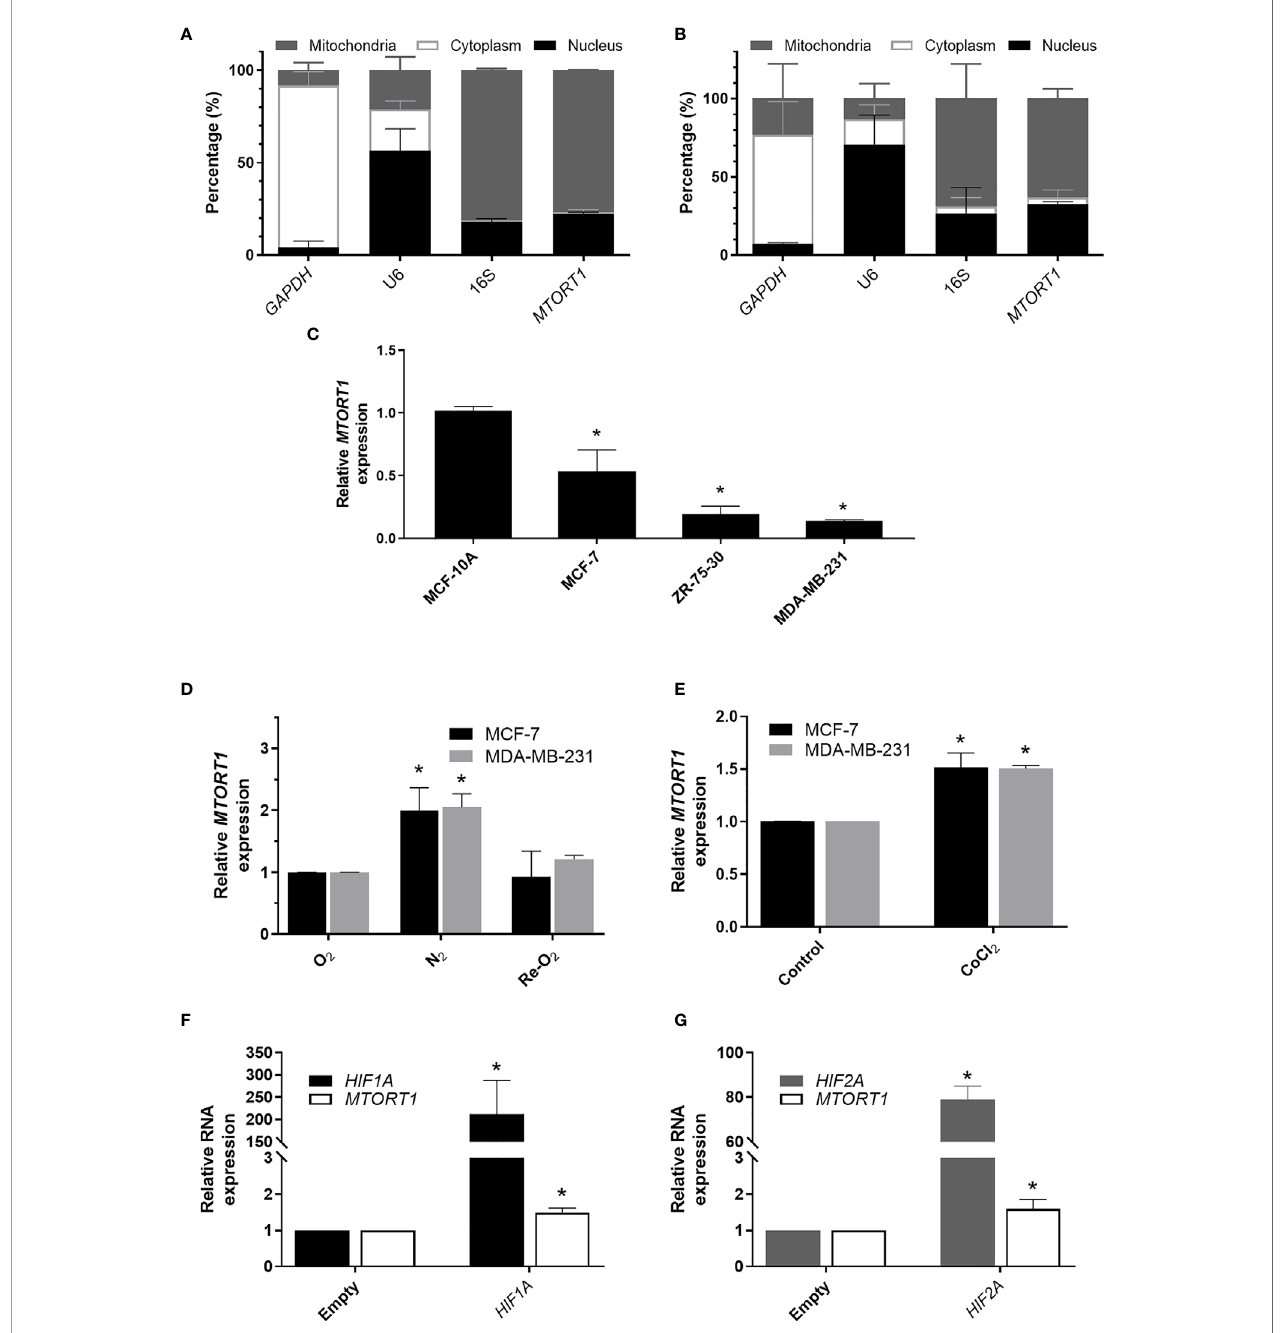
FIGURE 1 | The mitochondrial lncRNA MTORT1 is up-regulated under hypoxia and down-regulated under re-oxygenation in breast cancer cells. (A, B) The subcellular distribution of MTORT1 in MCF-7 cells under normoxia (A) or hypoxia (B) . Relative abundance of RNA was measured by quantitative RT-PCR and normalized to total RNA. GAPDH , a cytosolic marker; U6 , a nuclear marker; 16S , a mitochondrial marker. (C) Relative endogenous expression levels of MTORT1 in breast cancer cells, including MCF-7, ZR-75-30, and MDA-MB-231 cells, and MCF-10A breast epithelial cells. The expression levels were measured by quantitative RT-PCR and normalized to 18S rRNA. The relative expression levels in each cell line were compared with MCF-10A. (D) Relative expression levels of MTORT1 in MCF-7 and MDA-MB-231 cells under different oxygen concentrations were measured by quantitative RT-PCR and normalized to 18S rRNA. The relative expression levels of each condition were compared with the normoxic group. (E) Relative expression levels of MTORT1 in MCF-7 and MDA-MB-231 cells treated with 200 m M CoCl 2 for 24 h. (F) Relative expression levels of HIF-1A and MTORT1 in MCF-7 cells overexpressing HIF-1 a P402A/P564A mutant, which is resistant to VHL- mediated ubiquitination and degradation. (G) Relative expression of HIF-2A and MTORT1 in MCF-7 cells overexpressing HIF-2 a P405A/P531A mutant, which is resistant to VHL-mediated ubiquitination and degradation. The results are means ± SDs (n = 3). * P <